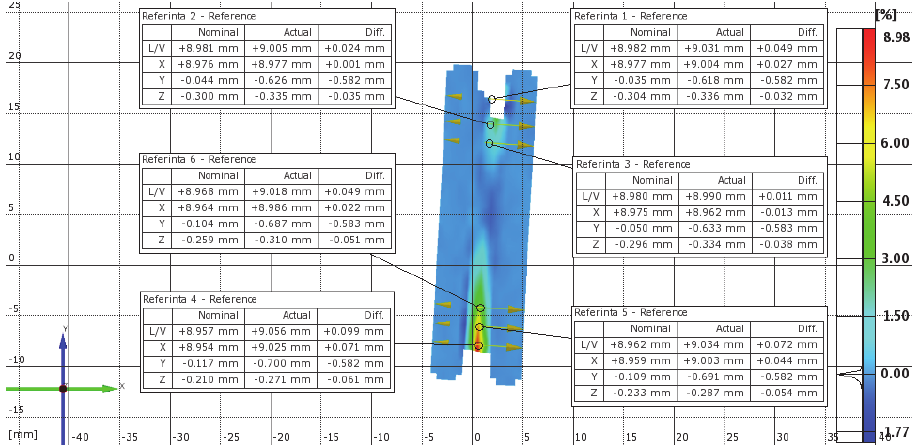
Figure 3: Peeling relative strains in the adhesive.